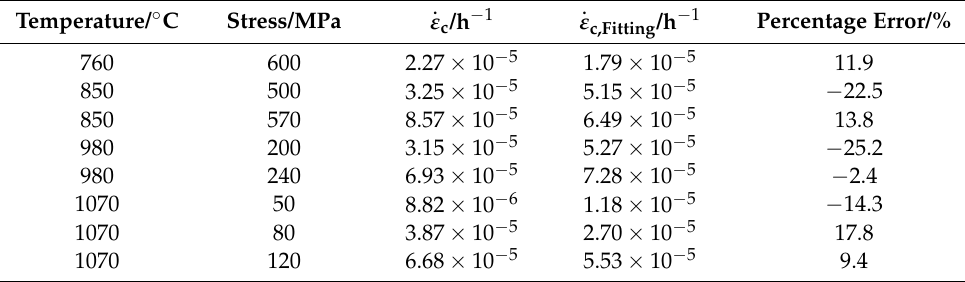
Table 4. [001] orientation creep strain rate prediction